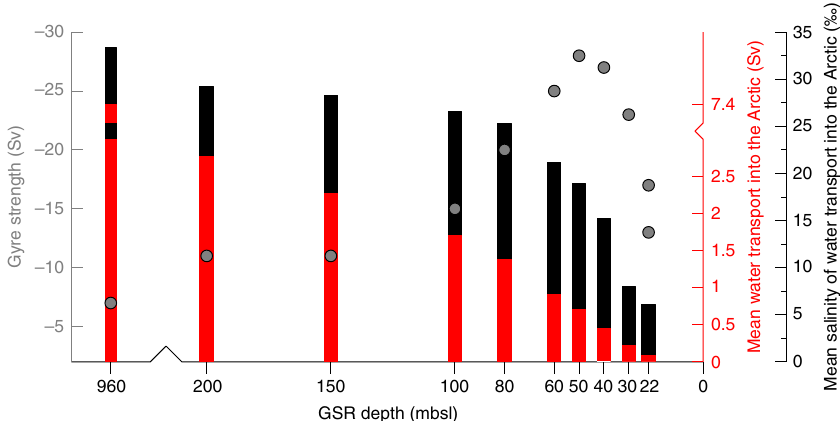
Figure 4 | Non-linear response of Greenland-Scotland Ridge sill depth changes on ocean characteristics. The Greenland-Scotland Ridge (GSR) deepening (mbsl, metres below sea-level) scales with a non-linear increase in mean salinity ( % , black bars) and water mass (Sv, red bars) import into the Arctic, whereas a local maximum in gyre strength (grey dots) is obtained by the circulation in the Greenland and Norwegian Seas, as indicated by the horizontal barotropic streamfunction